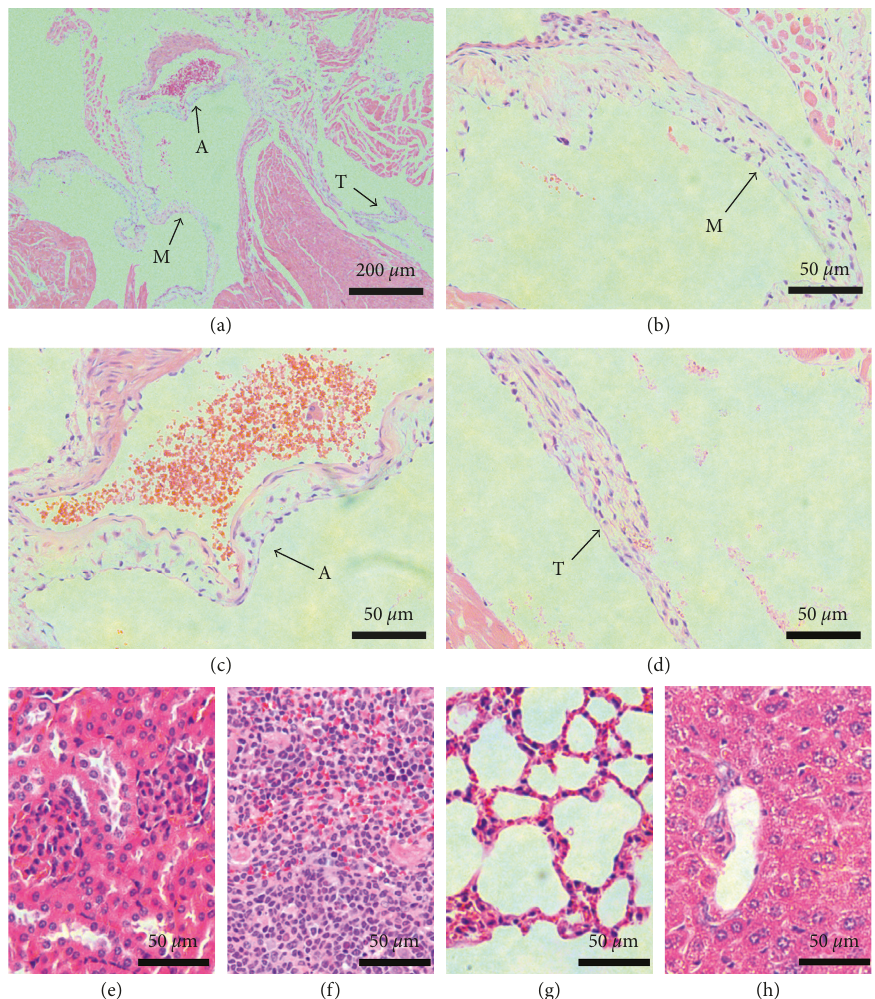
Figure 5: Histological analysis of tissues from mice immunized with high-dose peptide vaccine. Mice were immunized with 100 μ g peptide vaccine on days 1, 21, 31, and 41. Organs were collected 6 months after the last immunization. No autoimmune reactions were observed in these organs: (a) heart; (b) mitral valve; (c) aortic valve; (d) tricuspid valve; (e) kidney; (f) spleen; (g) lung; and (h) liver. M, mitral valve; A, aortic valve; T, tricuspid